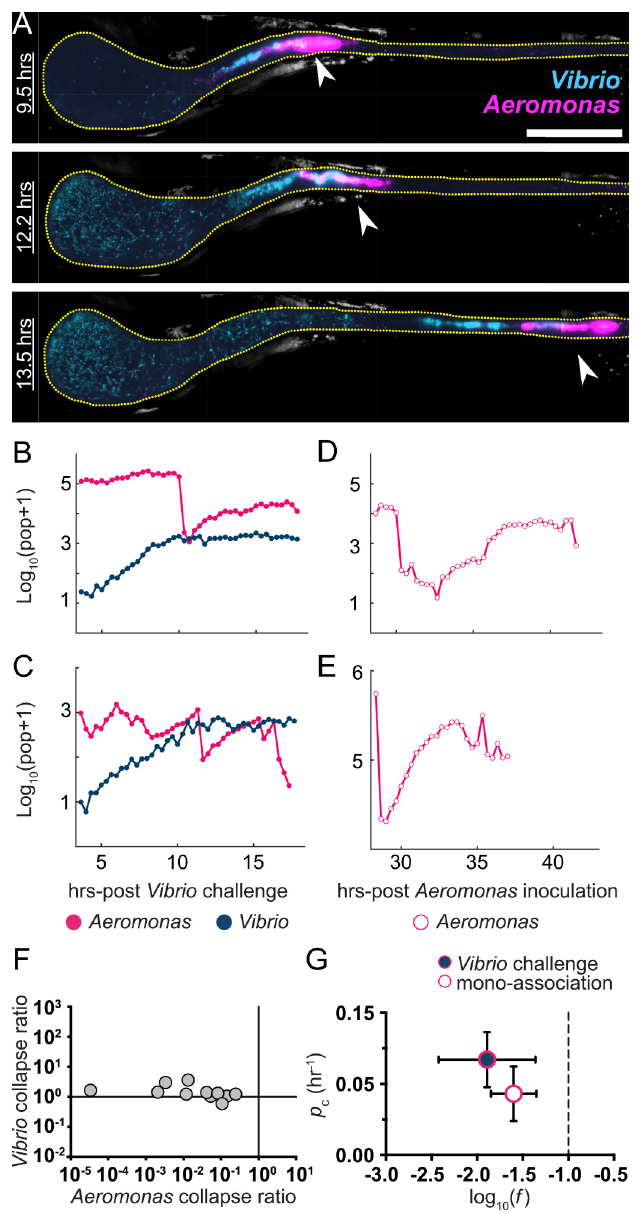
Fig 3. Aeromonas experiences sharp drops in population size that are intensified during Vibrio challenge. (A) MIPs of Aeromonas (magenta) and Vibrio (cyan) in a larval zebrafish intestine. Scale bar: 200 μ m. The fish was initially colonized at 4 dpf with Aeromonas , challenged 24 hr later by inoculation with Vibrio , and then imaged every 20 min for 14 hr. The times indicated denote hours post-challenge. In all images, the region shown spans about 80% of the intestine, with the anterior on the left. Image contrast in both color channels is enhanced for clarity. Yellow dotted line roughly indicates the lumenal boundary. As time progresses, the anterior growth of Vibrio as well as abrupt changes in the Aeromonas distribution (arrows) are evident. (B,C) Total bacterial abundance, derived from image data, for Aeromonas and Vibrio in two representative fish inoculated and challenged as in panel A, as a function of time following the Vibrio inoculation. Sharp drops of over an order of magnitude in the Aeromonas population, but not the Vibrio population, are evident. (D,E) Total abundance for Aeromonas in mono-associations as a function of time post-inoculation, in two representative fish. Sudden declines are also observed, though in general the populations recover to approximately pre-collapse levels. (F) The ratio, f , of the abundance immediately after to that before population drops, for Aeromonas challenged by Vibrio ; this ratio spans many orders of magnitude (horizontal axis). At the same time points, the Vibrio populations are essentially unchanged,